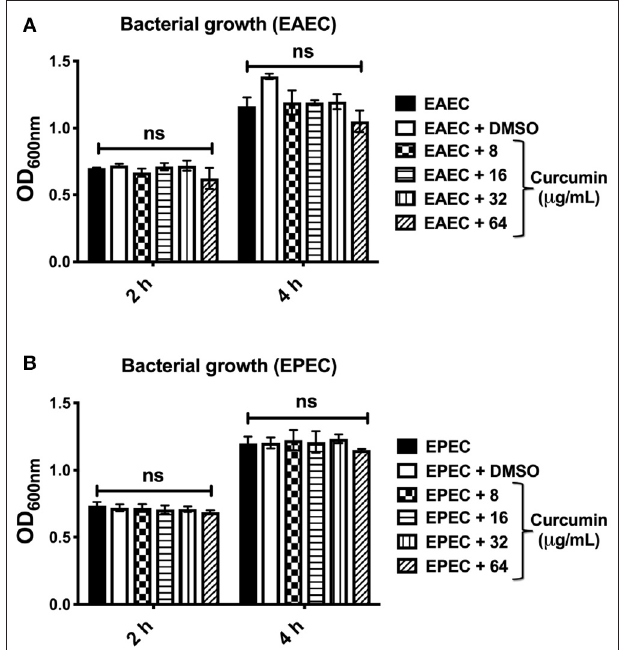
FIGURE 1 | Curcumin has no toxic effect on EAEC and EPEC bacterial strains. Bacterial strains EAEC 042 (A) and EPEC E2348/69 (B) were grown in LB broth to an initial optical density of 0.05 (OD 600nm ), when the bacteria reached an exponential growth phase, different concentrations of curcumin were added (8, 16, 32, 64 µ g/mL) for 2 and 4h at 37 ◦ C at 150 rpm. Bacterial strains without curcumin (black bars) or with vehicle DMSO (white bars) served as internal control. The values in all the graphs represent means ± SEM for at least three independent experiments. Statistical significance was determined by using a two-way ANOVA test followed by a Tukey post-hoc test, no significance (ns) ( p >